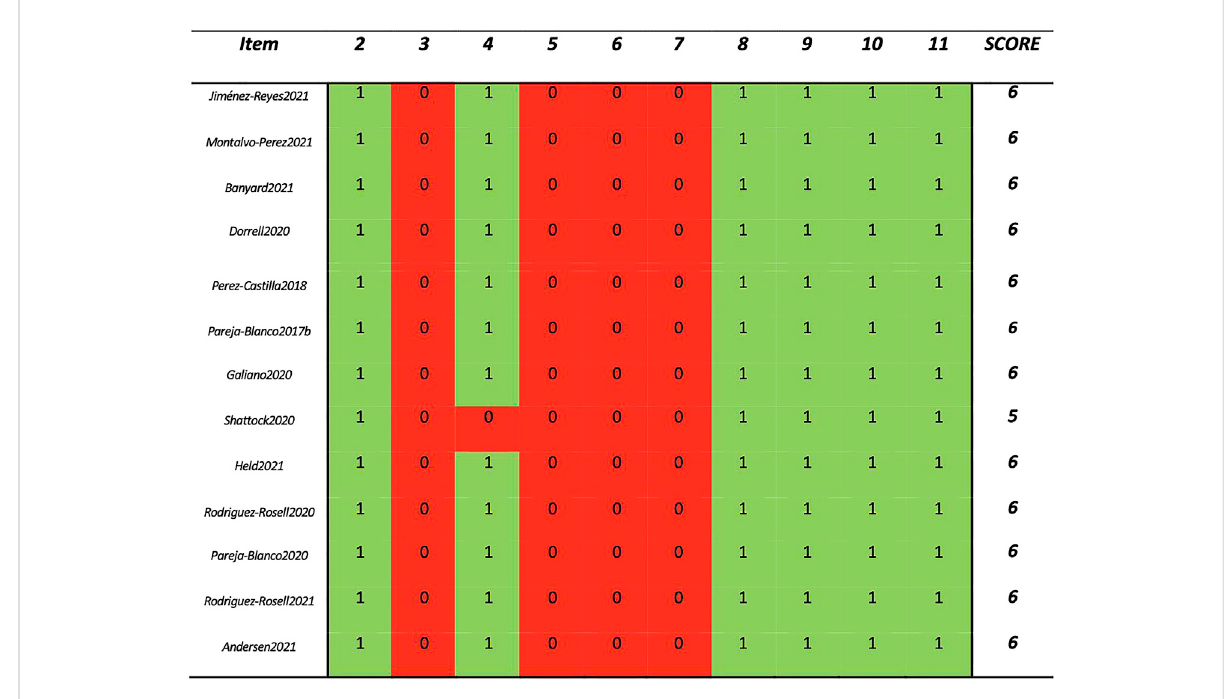
FIGURE 2 PEDro Score of each included study.